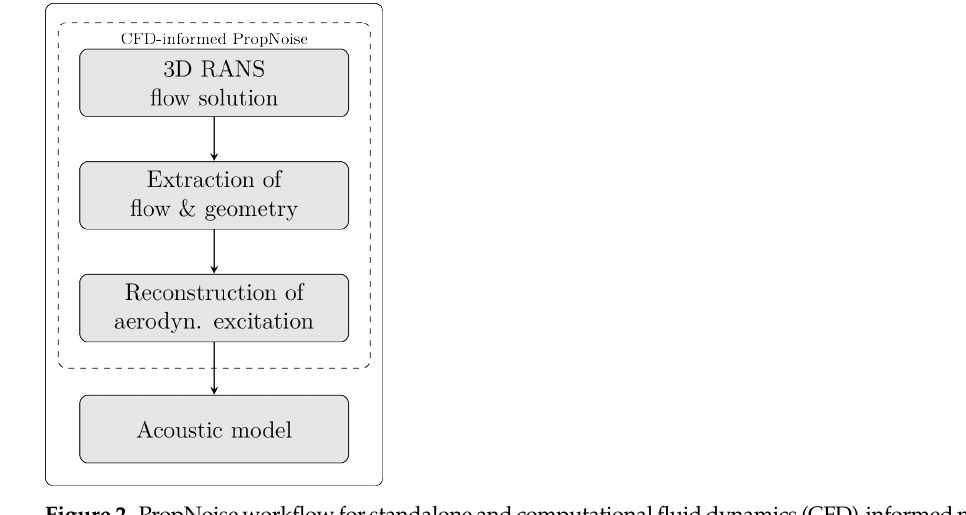
Figure 2. PropNoise workflow for standalone and computational fluid dynamics (CFD)-informed